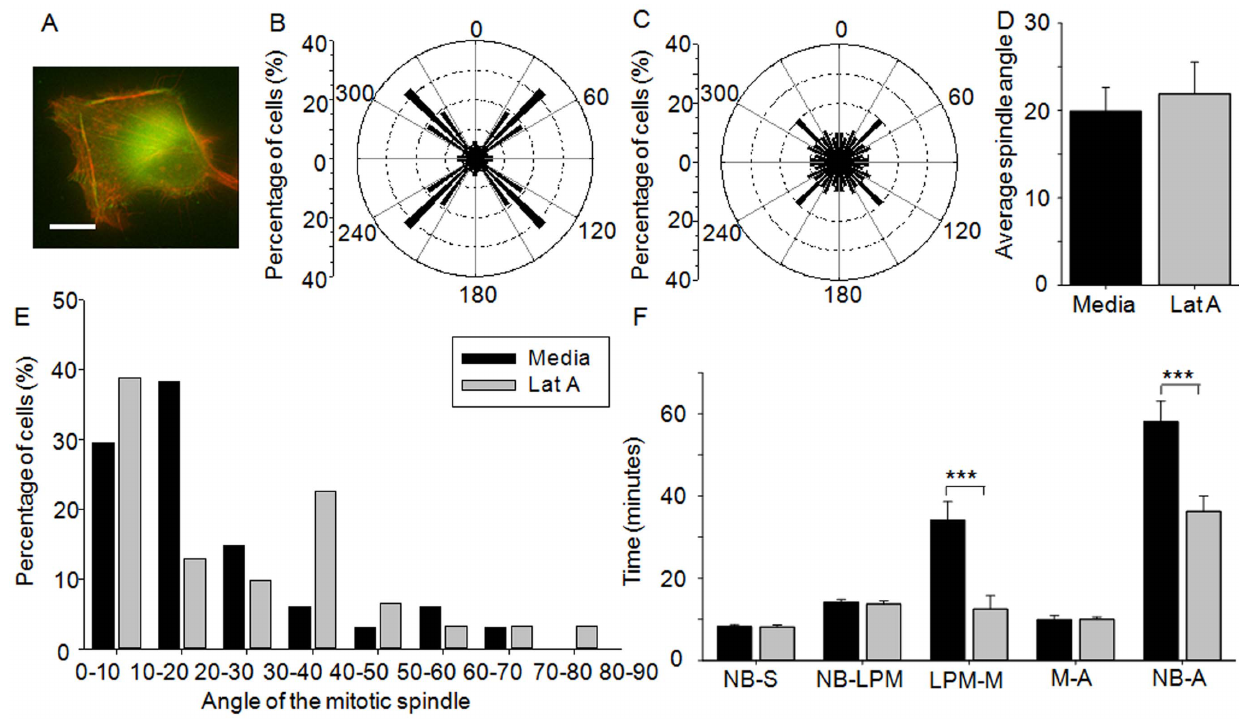
Figure 6. The effect of the actin cytoskeleton on mitosis after culture on 2D square patterned substrates. (A) HeLa cells (YFP-paxillin) were cultured on 2D square patterns for 18 hours and imaged during interphase for actin (red) and paxillin (green). HeLa cells (RFP-tubulin/GFP-H2B) were assessed for the angle of the mitotic spindle in the xy plane at metaphase after culture on 2D square patterns and treatment with (B) media or (C) latrunculin A. A high proportion of the cells cultured on square patterns aligned the mitotic spindle along the diagonal of the cell, which was reduced by the addition of latrunculin A. (D) Conversely the addition of latrunculin A had little effect on the average orientation of the mitotic spindle perpendicular to the substrate plane. Values represent spindle angle in degrees 6 SEM. (E) Furthermore, the addition of latrunculin A had little effect on the distribution of the spindle orientation. (F) Cells treated with latrunculin A (light grey bars) took significantly less time to progress from late prometaphase to metaphase and to complete mitosis than untreated cells (black bars). All values represent time in minutes 6 SEM. Key: *** p , 0.001; NB = nuclear envelope breakdown, S= spindle formation, LPM = late prometaphase, M= metaphase, A= anaphase.